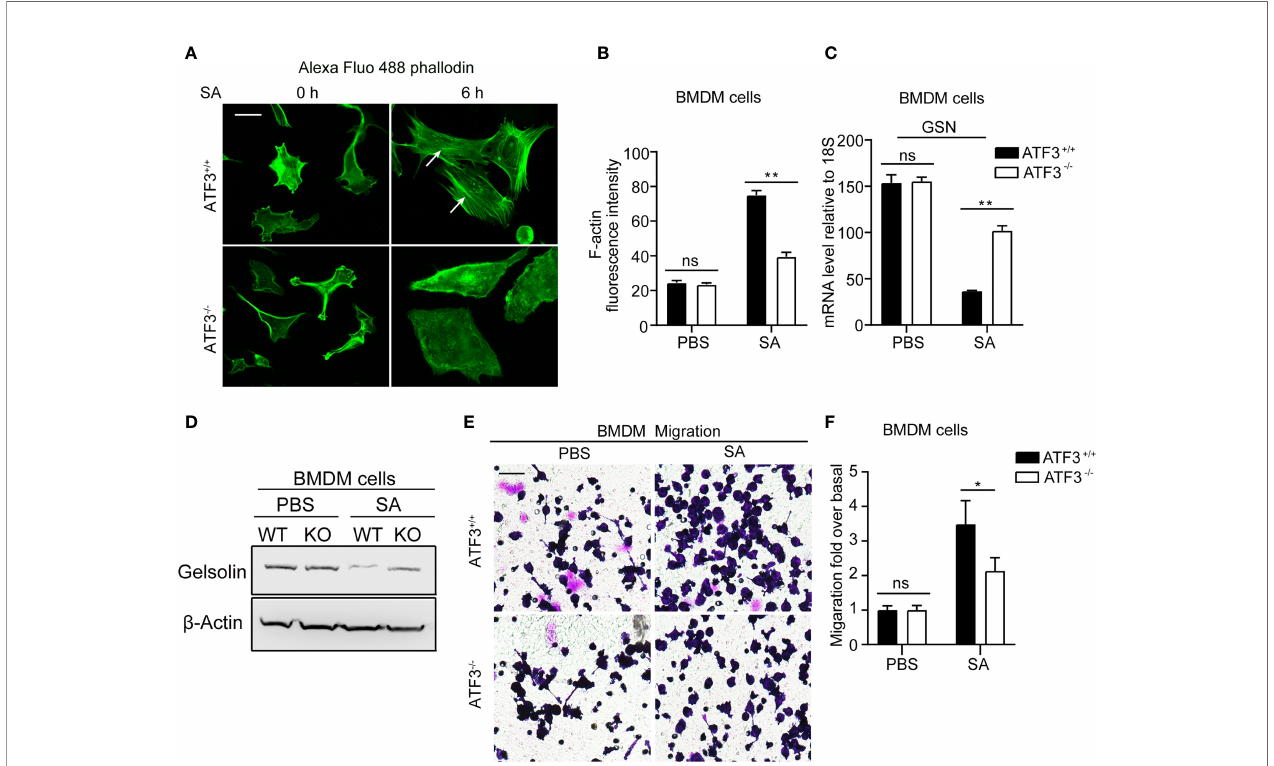
FIGURE 7 | ATF3 regulates GSN and cytoskeleton remodeling for macrophage motility and recruitment. (A) Representative images of the actin cytoskeleton stained with phalloidin in WT and ATF3 KO BMDM cells and cells infected with S. aureus (MOI = 1). The white arrow indicates F-actin. (B) The intensity of F-actin is quanti fi ed on the right (* P < 0.05). (C, D) The GSN expression was analysis by the qPCR analysis and immunoblotting assay between WT and ATF3 KO BMDM cells with or without S. aureus infection. (E) The effect of S. aureus infection on WT and ATF3 KO BMDM cells migration was evaluated by trans-well assay in 24h. (F) Quantitative analysis of the cell migration ratio in (E) . ns, P > 0.05, * P < 0.05, ** P <